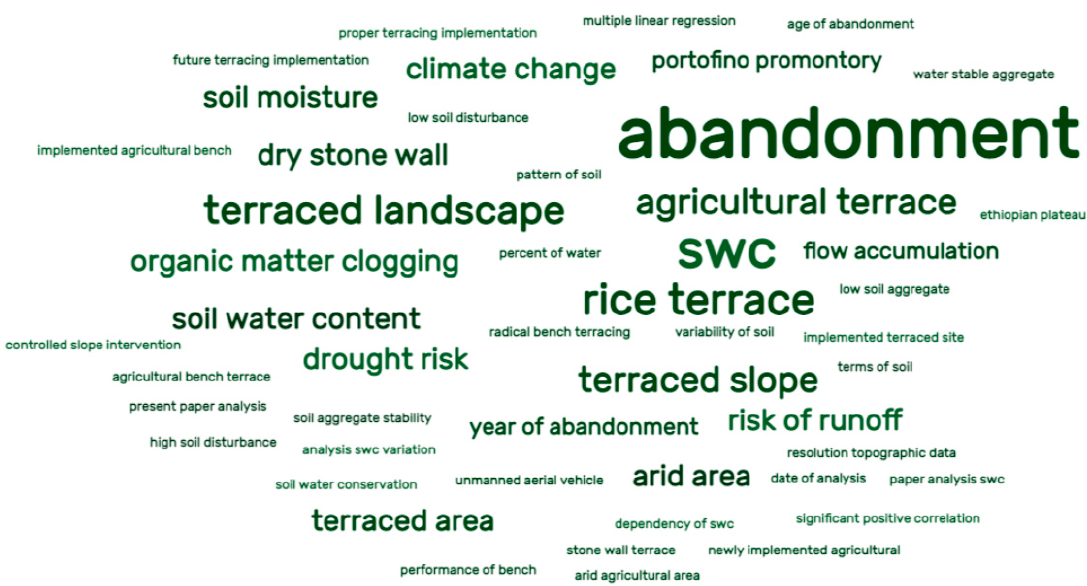
Figure 3. Word cloud generated from titles, keywords, and abstracts of the Special Issue, with the most frequent words in the largest font. “Abandonment” was the most frequent term, with 20 occurrences.